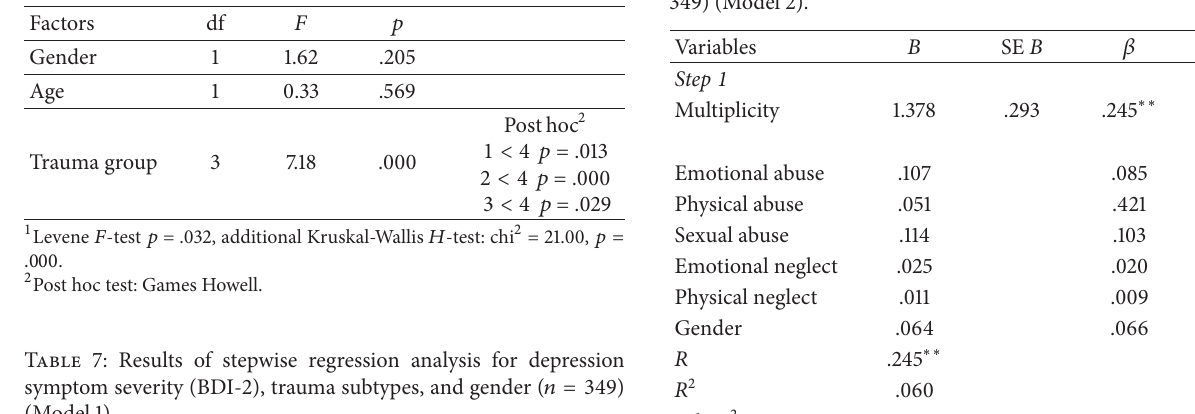
Table 6: Analysis of variance (ANOVA) according to trauma group conducted for BDI-2 and age and gender as covariates 1 .